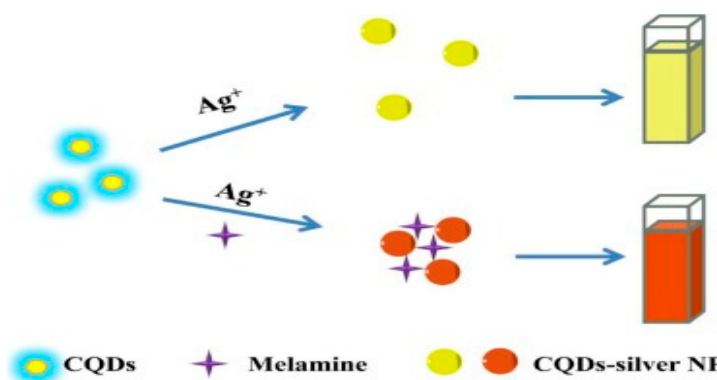
Figure 10. Schematic illustration of the colorimetric sensing of melamine based on in situ formation of CQDs-silver NPs (reproduced with permission from Reference [70]).